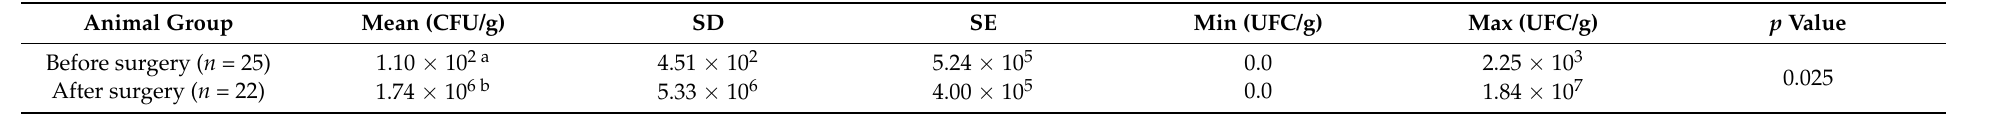
Table 3. Descriptive statistics of ESBL/AmpC-producing Enterobacteriaceae load (CFU/g of feces) per dog before surgery ( n = 25) and after surgery ( n = 22) by the General linear model